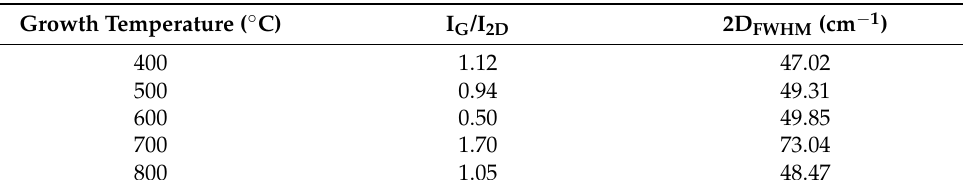
Figure 1. Raman spectra of graphene thin films grown with different growth temperatures. Spectra were collected when the graphene thin films were still on the copper foil surfaces. Table 1. Characteristics value of Raman spectra regarding the G and 2D position, the intensity ratio between them and the 2D FWHM are shown.